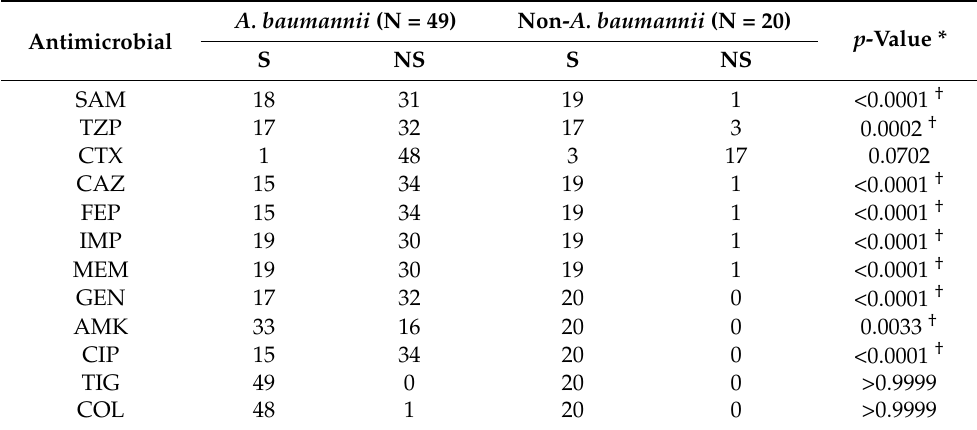
Table 2. Antimicrobial susceptibility profile for A. baumannii and non- A. baumannii groups.